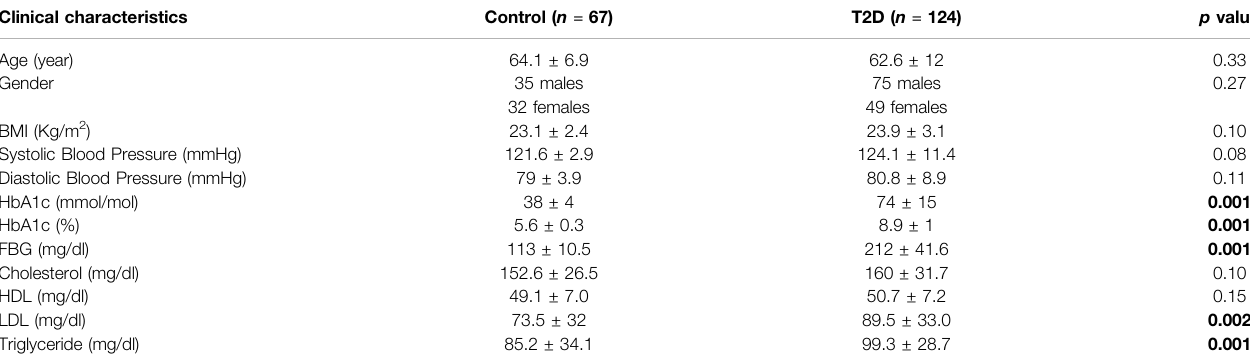
TABLE 1 | Clinical characteristics for the participants. Clinical characteristics